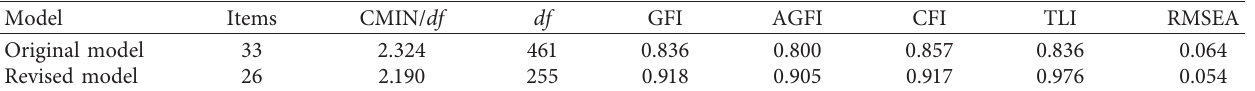
Table 10: Model fit summary (original and revised model